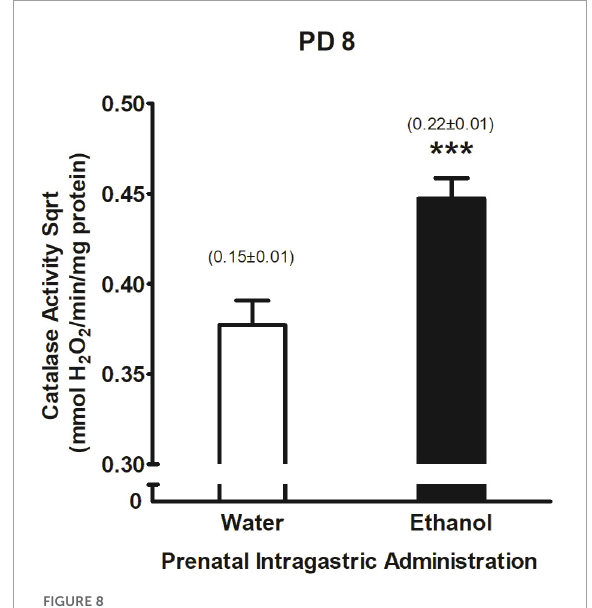
FIGURE8 Catalase activity Sqrt (mmol H 2 O 2 /min/mg protein) as a function of prenatal intragastric at PD 8. *** p < 0.001 indicates that pups prenatally exposed to ethanol are different from those in the water-treated group. Catalase activity values were transformed using a square root transformation. Numbers in brackets indicate catalase values without transformation (mean ± SEM). Vertical lines illustrate standard errors of the mean